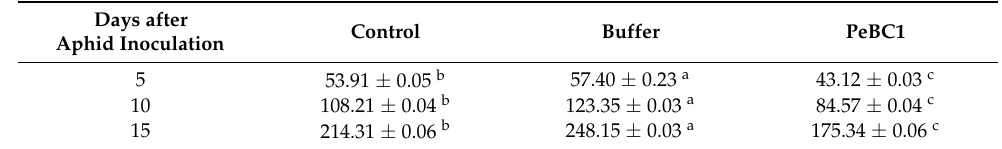
Table 2. M. persicae population variations were seen in PeBC1-, control-, and buffer-treated chili seedlings. To compare data, one-way analysis of variance (ANOVA), Levene’s test with SPSS 18.0, and the least significant difference (LSD) were employed. After inoculation of aphid on the same day, significant changes in letters in rows can be noticed in all treated samples ( p = 0.05).